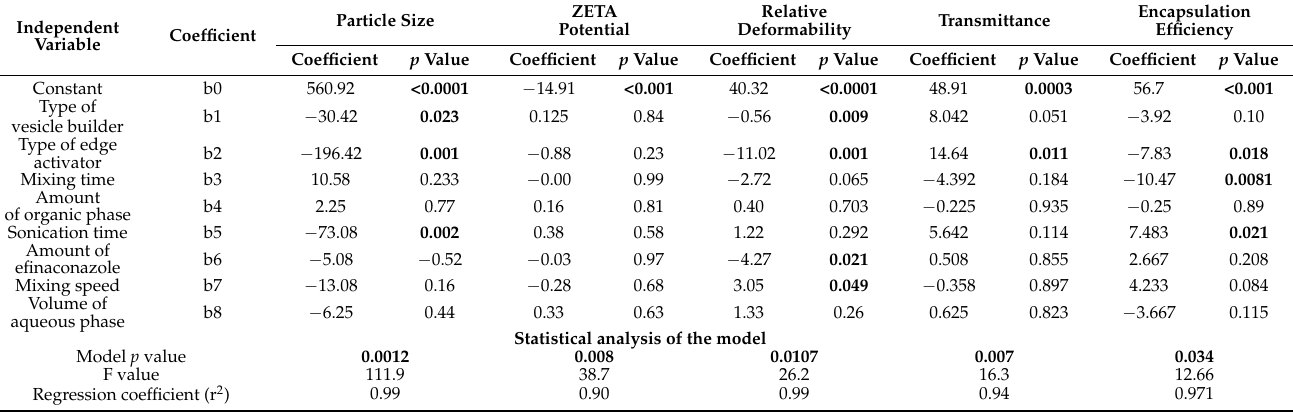
Table 5. Various statistical parameters were derived and analysis of variance (ANOVA) for the 12 runs of PBSD was employed for eight independent variables for particle size (Y 1 ), zeta potential (Y 2 ), relative deformability (Y 3 ), transmittance (Y 4 ), and encapsulation efficiency (Y 5 ). Significant values are in bold